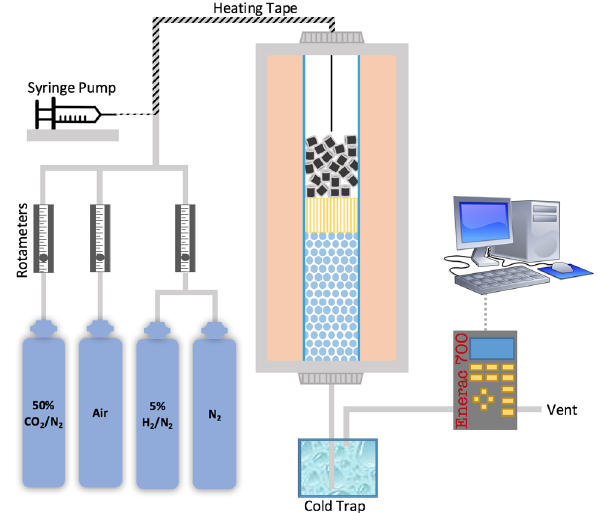
Figure 9. Diagram of scaled-up fixed bed reactor. The N 2 cylinder was used either exclusively or simultaneously with the 50% CO 2 /N 2 cylinder to dilute the CO 2 concentration to 7.5% for feeding. The computer connected to the Enerac unit equipped with infrared/electrochemical sensors recorded data every second. Total flow rate of each gas feeding was 300 mL/min.